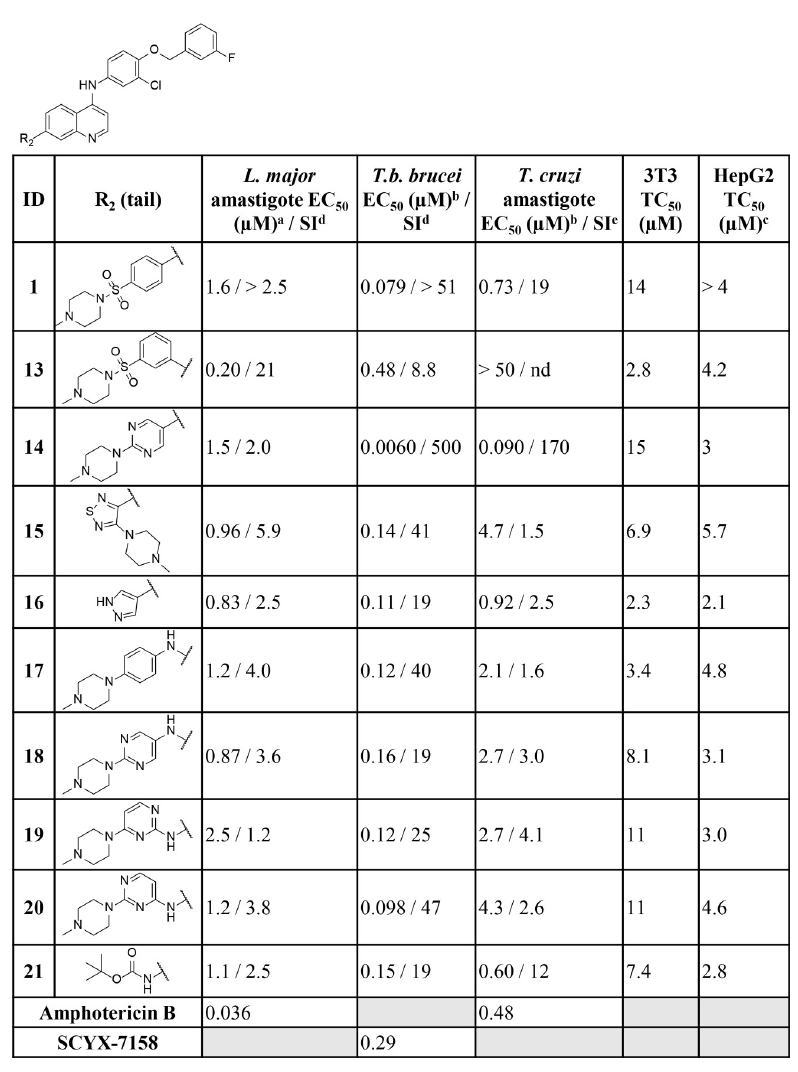
Fig 3. Biological activity of key compounds with varying tail groups (denoted by R 2 ) against L . major amastigote, T . b . brucei , T . cruzi cultures and HepG2 human cells. Data for the full screening set is summarized in the supplementary information. nd = not determined a All r 2 values are > 0.9 unless noted otherwise b All SEM values within 25% except for 1 where EC 50 T . cruzi 0.73 (SEM: 0.2; 27%) c Tested concentration ranges were determined based on compound solubility d Selectivity index (SI) calculated relative to HepG2 cells. e Selectivity index (SI) calculated relative to 3T3